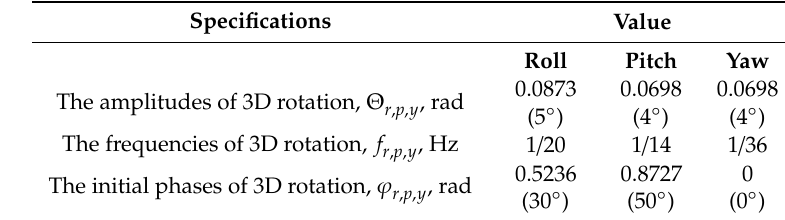
Table 2. The parameters of the rotational motion of the